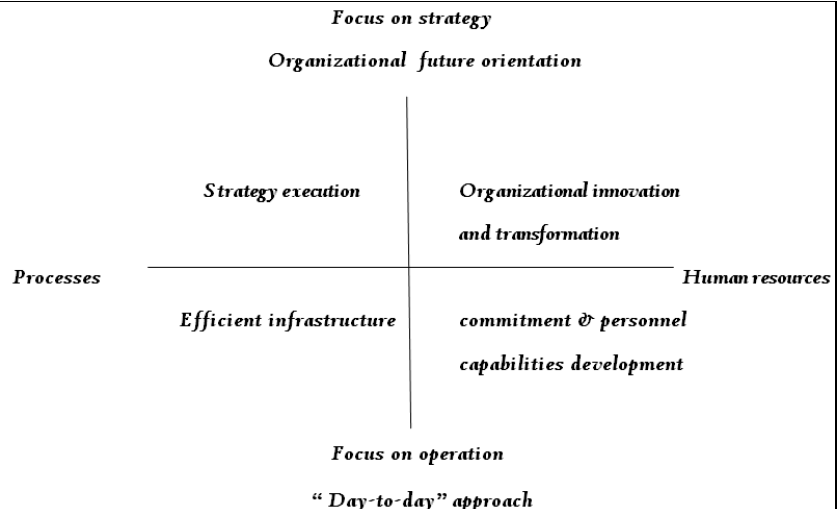
Figure 3: The Intangible Assets Model Extension